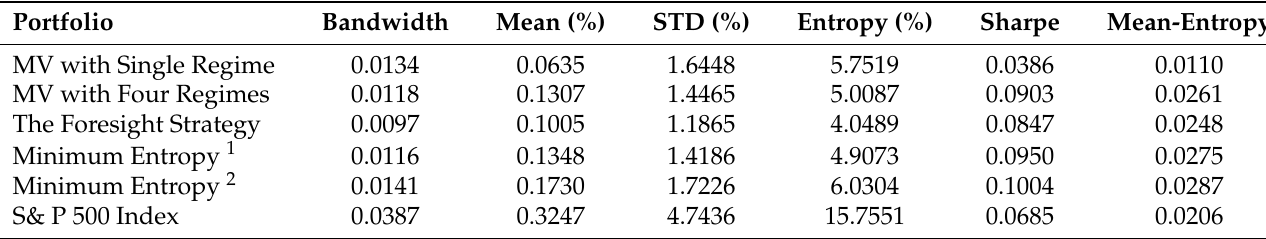
Table 8. The Sharpe and mean entropy